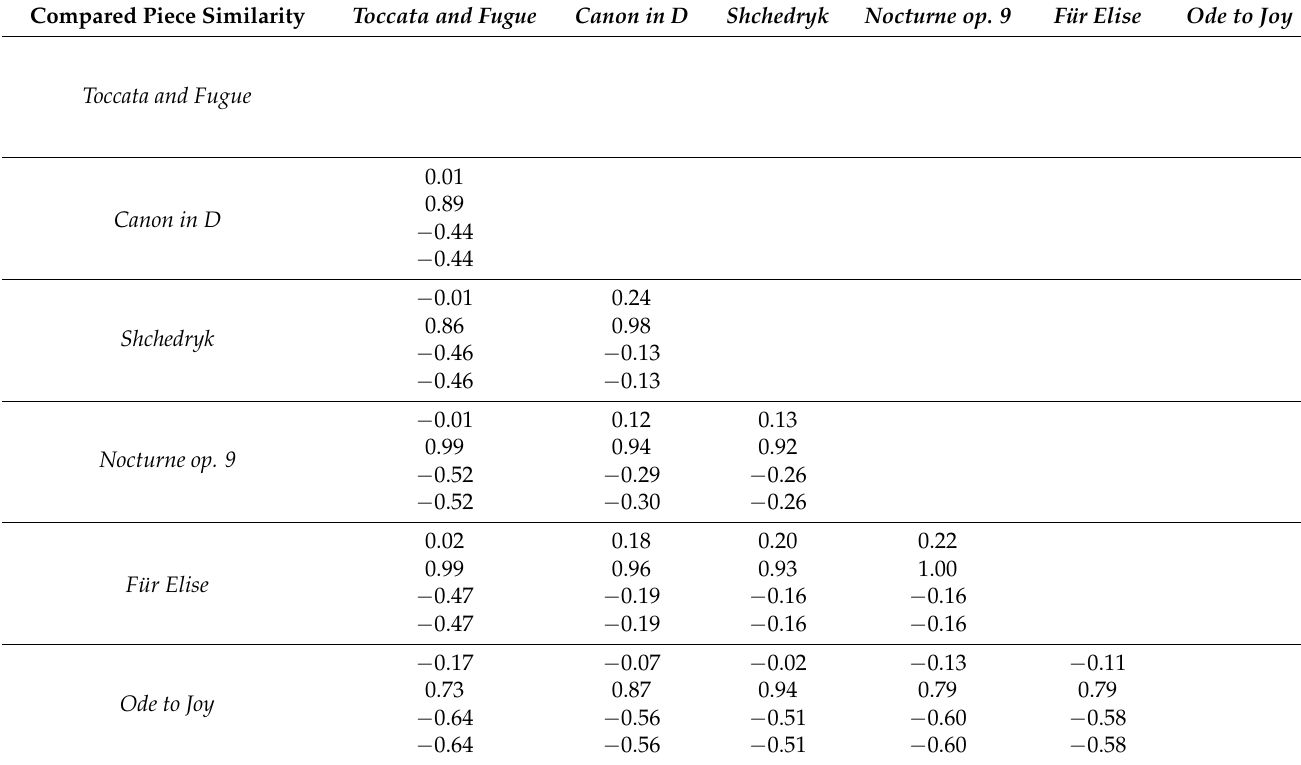
Table 2. Comparison of pieces from the classical music genre. Compared Piece Similarity Toccata and Fugue Canon in D